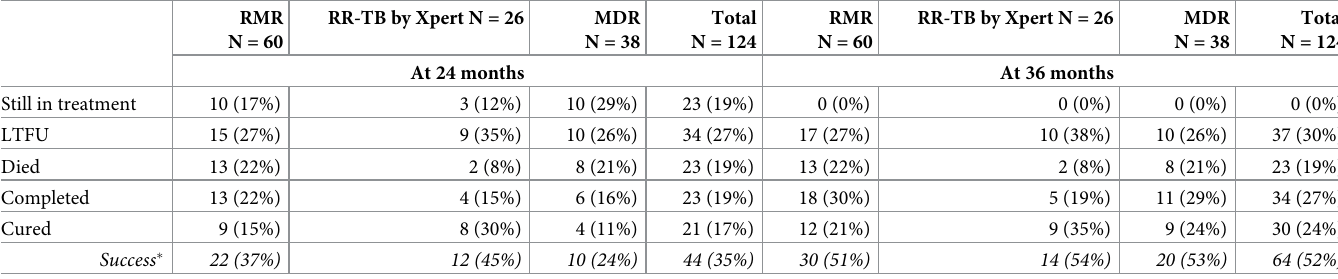
Table 2. Patient outcomes by resistance type.